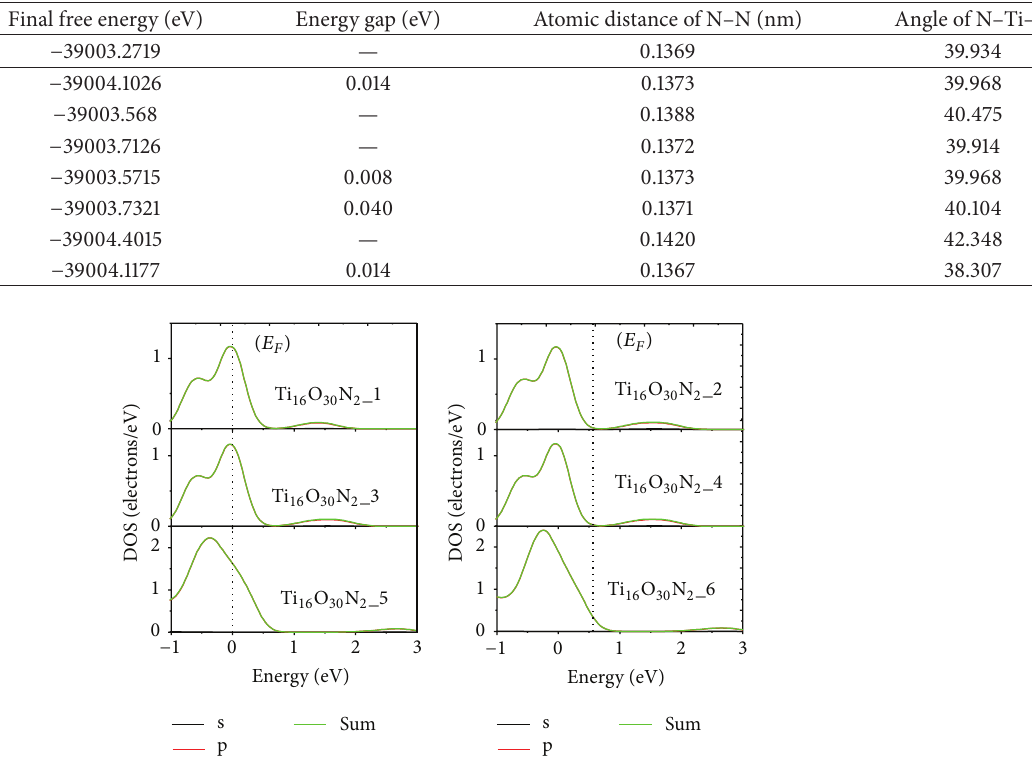
Table 4: The total energy and band gaps of rutile and eight kinds of neutral doped rutile TiO N–N and angle of N–Ti–N.